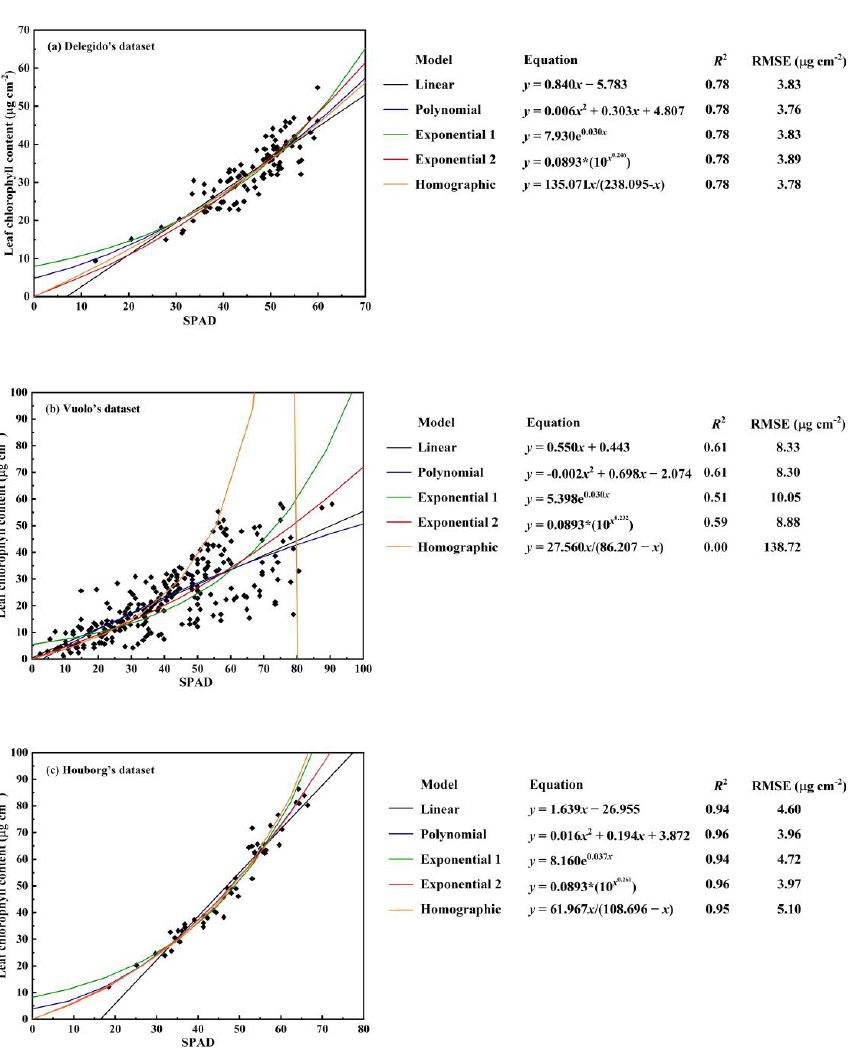
Figure 2. The assessments of five functions for the estimation of the LCC of all species in Delegido’s ( a ), Vuolo’s ( b ), and Houborg’s dataset ( c ). The right panel corresponds to the statistics of the five function evaluations for each dataset in the left panel.